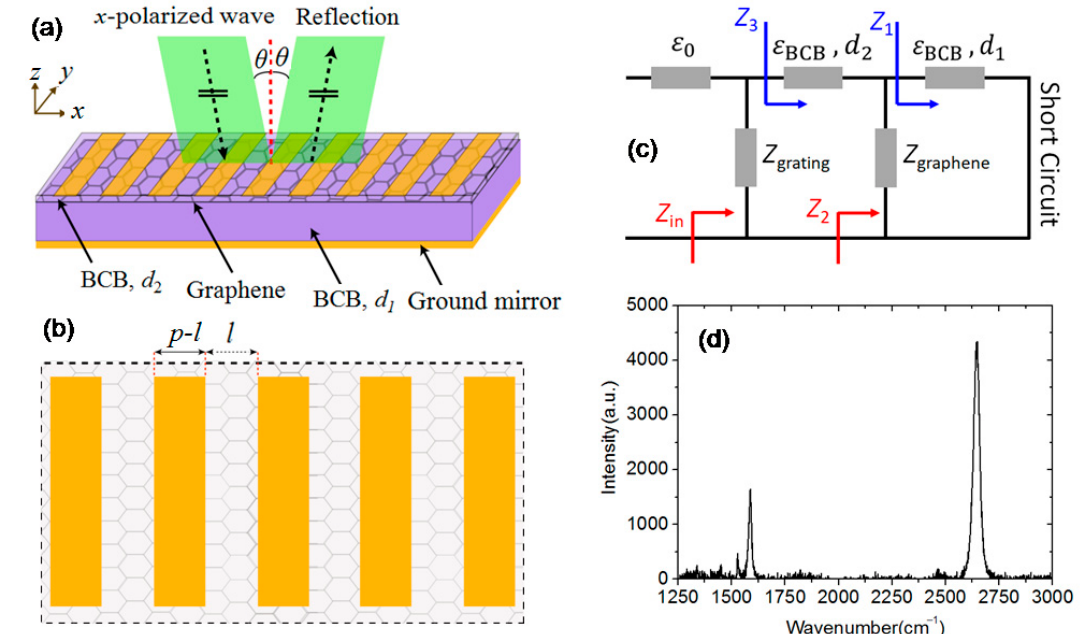
Figure 1. The schematic structure of device ( a ) the three-dimensional view and ( b ) the top view, ( c ) equivalent circuit of the MGDM-graphene structure, and ( d ) Raman spectrum of the transferred graphene sheet.